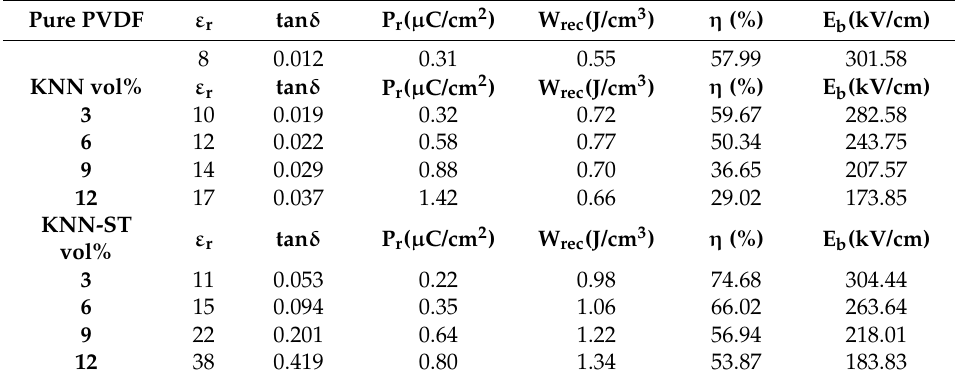
Table 1. Dielectric properties of pure PVDF, KNN/PVDF and KNN-ST/PVDF composite films. Figure 5. Dielectric constant and dielectric loss on frequency of KNN-ST/PVDF composite films.